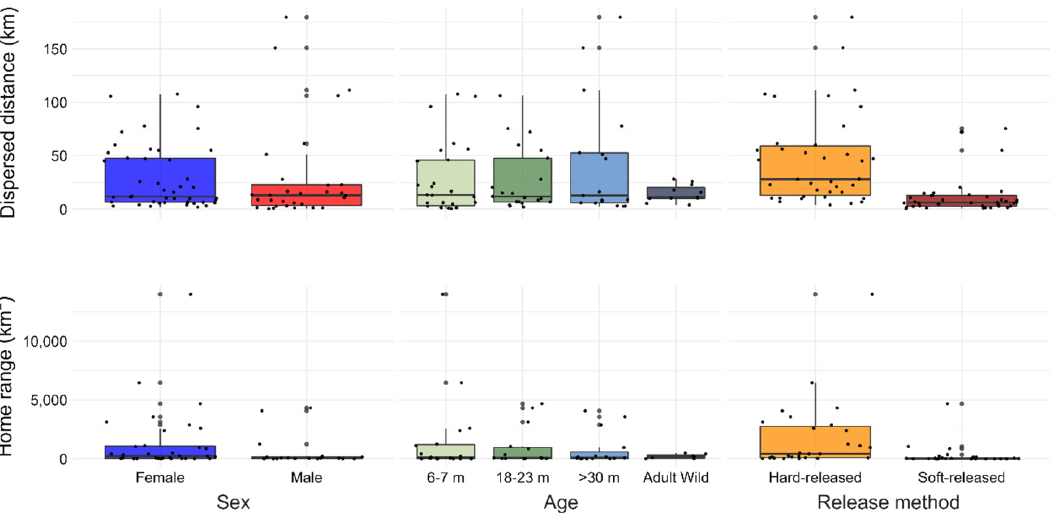
Figure 2. Dispersal and home ranges among sex, age at release and release method of captive-reared and wild-rehabilitated Harpy Eagles ( Harpia harpyja ) in Central American landscapes.